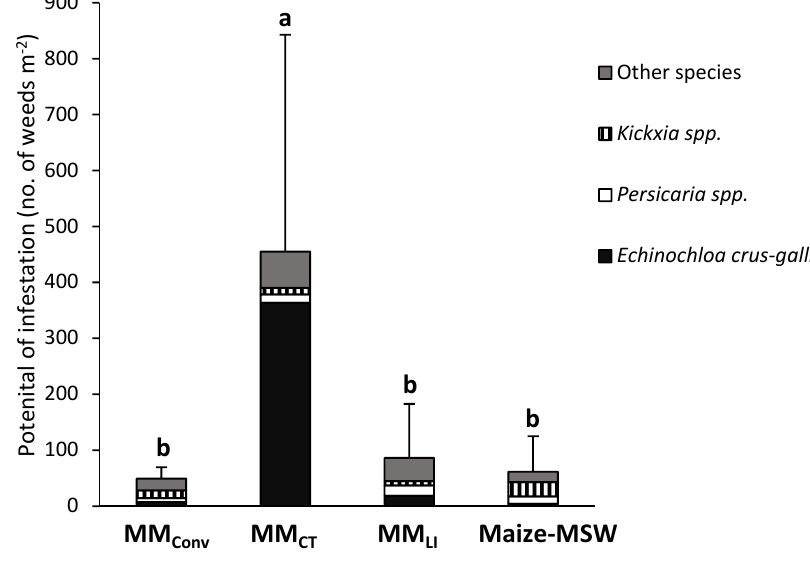
Figure 2. Potential of infestation (PI, see equation for details) detailed for the three main weed species (mean values over the 5-year period, 2011–2015) in the four cropping systems (MM Conv : conventional maize monoculture; MM CT : conservation tillage maize monoculture; MM LI : low-input maize monoculture; Maize-MSW: integrated maize rotation, N = 10 quadrats per cropping system). Year and block were treated as random factors. Error bars represent standard deviations. ANOVA tested a system effect p < 0.001). Bars sharing the same letter (“a” and/or ”b”) are not significantly different ( p < 0.05, Tukey HSD Test).